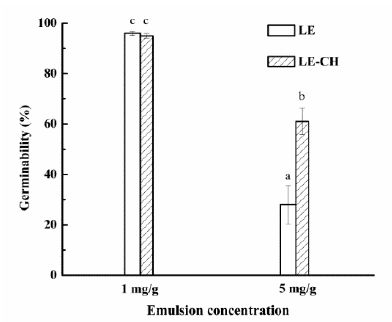
Figure 8. Effect of chitosan on germinability of Litsea cubeba oil emulsion. LE represents Litsea cubeba essential oil primary emulsion and LE-CH represents Litsea cubeba essential oil secondary emulsion.